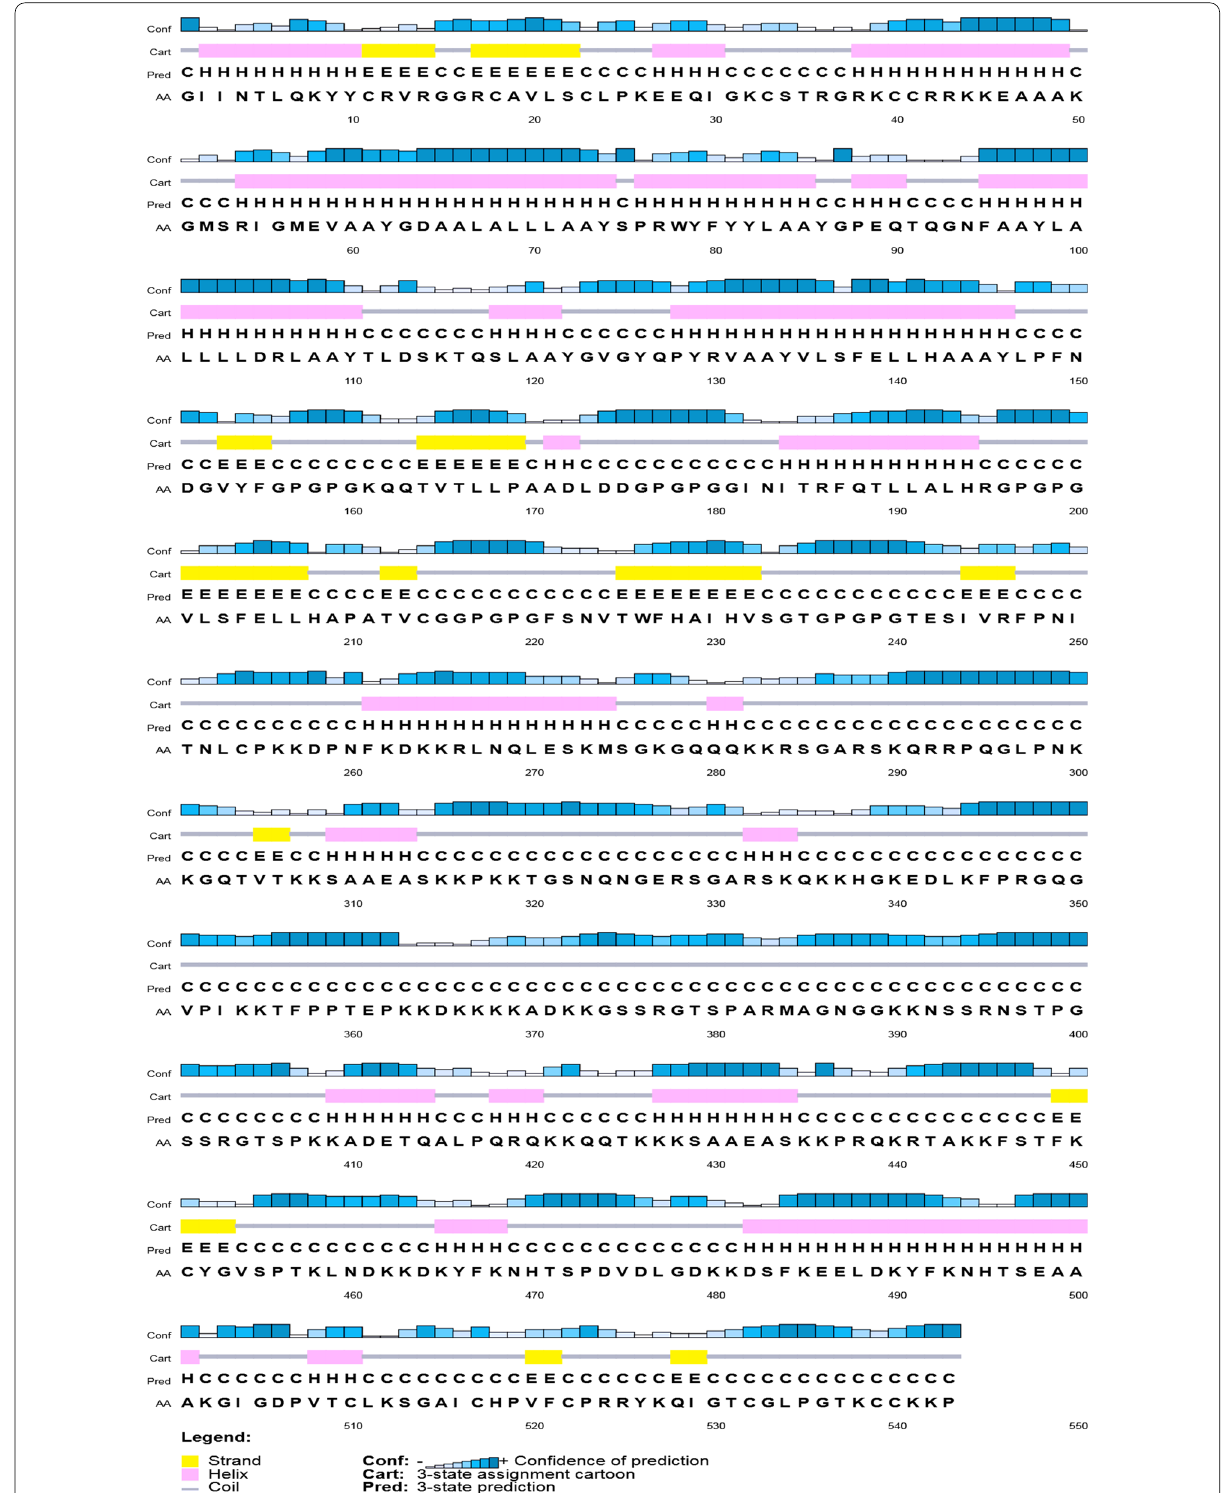
Fig. 3 Two-dimensional analysis of the structure of the vaccine designed by the PSIPRED